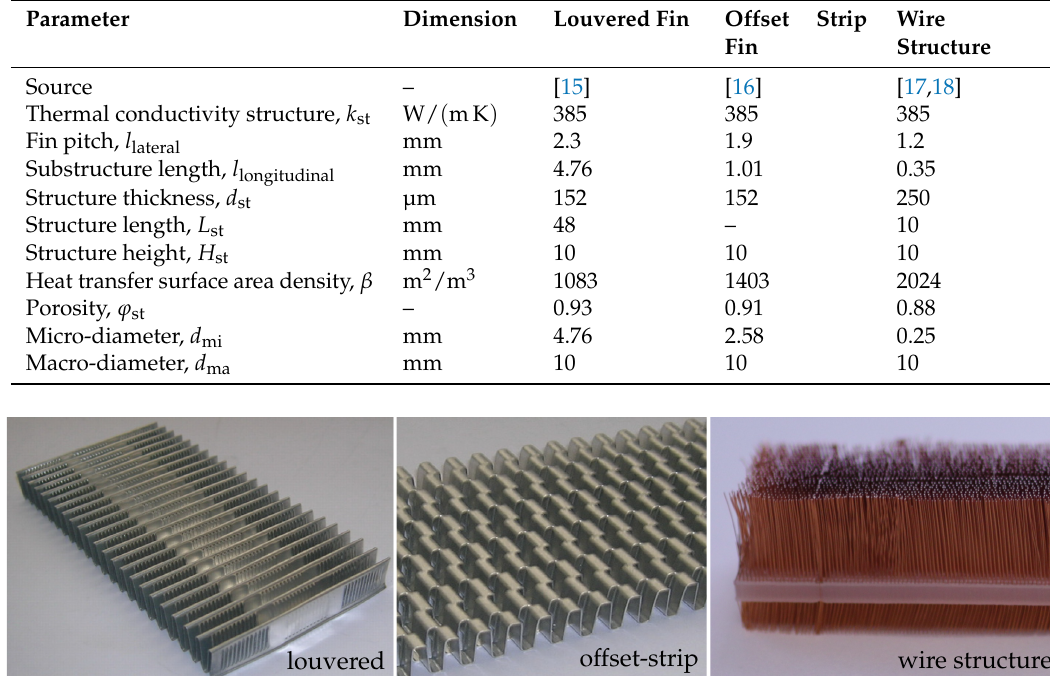
Figure 3. Geometry examples of a louvered fin [19], and offset strip fin [20], and a wire structure pin fin enhancement used for the visualization method.